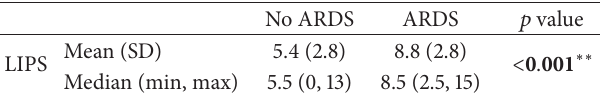
Table 2: Average LIPS for patients with and without the develop- ment of